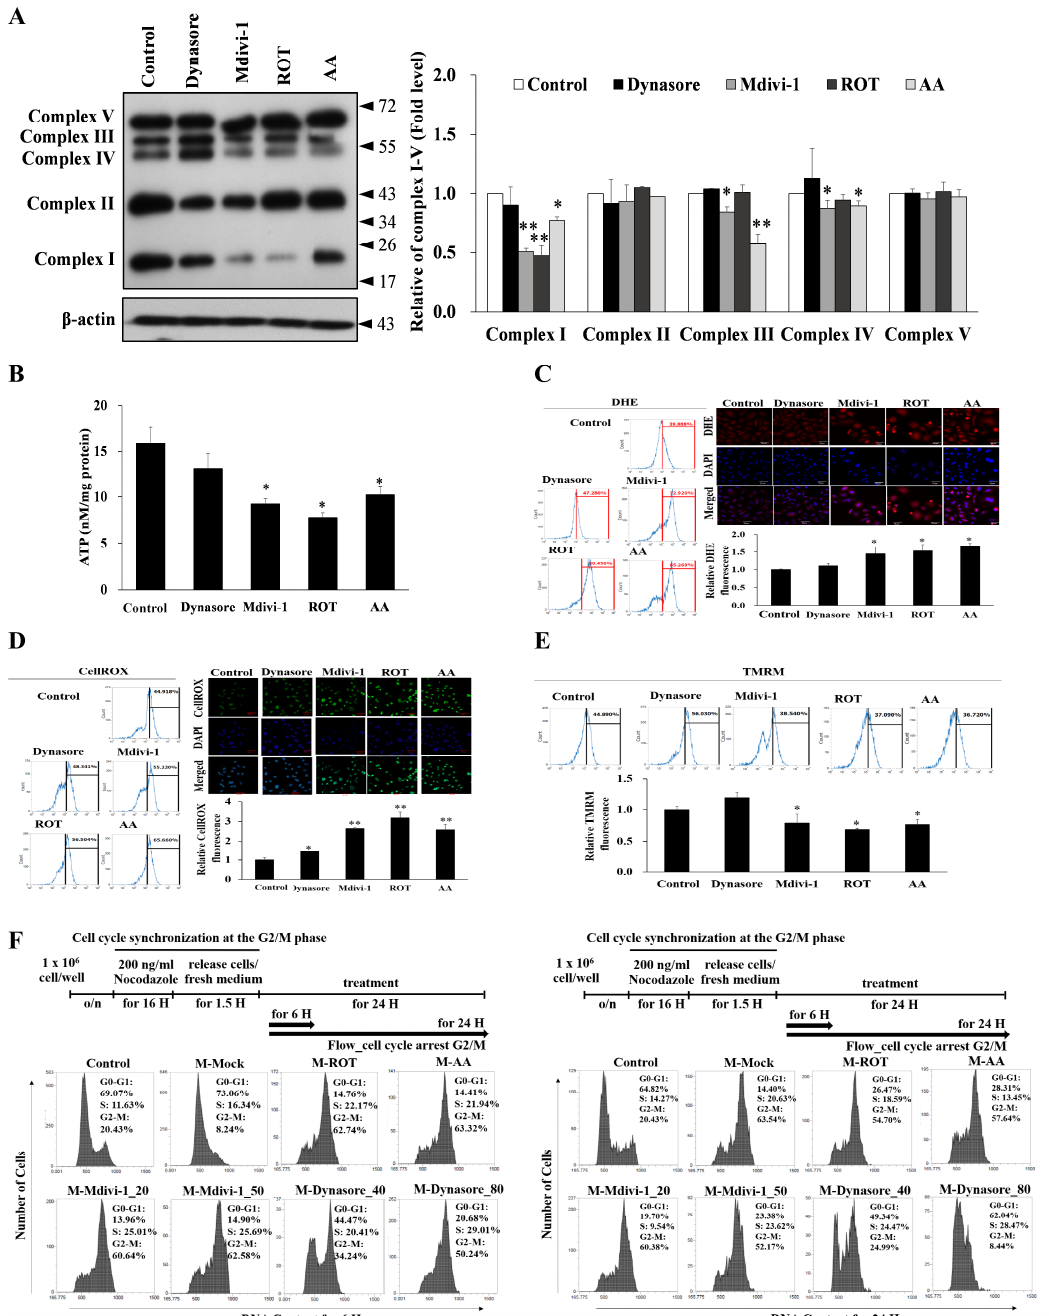
Figure 4. Increase in multipolar spindles is associated with mitochondrial ETC blockade and cell-cycle progression in HeLa cells. ( A ) Immunoblotting analysis of OXPHOS mitochondrial complexes in ROT (200 nM), AA (10 µ M), Mdivi-1 (20 µ M), and Dynasore (40 µ M) treated HeLa cells. ( B ) Normalized ATP measurements in HeLa cells. ( C – E ) The mitochondrial ROS, cytosolic ROS and mitochondrial membrane potential ( ∆Ψ m) levels were measured using flow cytometry and fluorescence microscopy with DHE Deep Red, CellROX Deep green, and TMRM Deep Red staining, respectively, and indicated by the mean fluorescent intensity (MFI), or percentage of the cells. ( F ) Mitochondrial ETC delays cell-cycle G2–M to G1 phase transition. FACS analyses were carried out using cells released from nocodazole block in the presence of ROT, AA, Mdivi-1, and Dynasore for 16 and 24 h. Cell cycle distribution was determined by flow cytometric analysis of propidium iodide-stained cells. Cell number (%) in each cell-cycle phase is indicated in the graph. The bar graph represents the mean of triplicates ± SD. * p < 0.05, ** p < 0.01 compared with the control